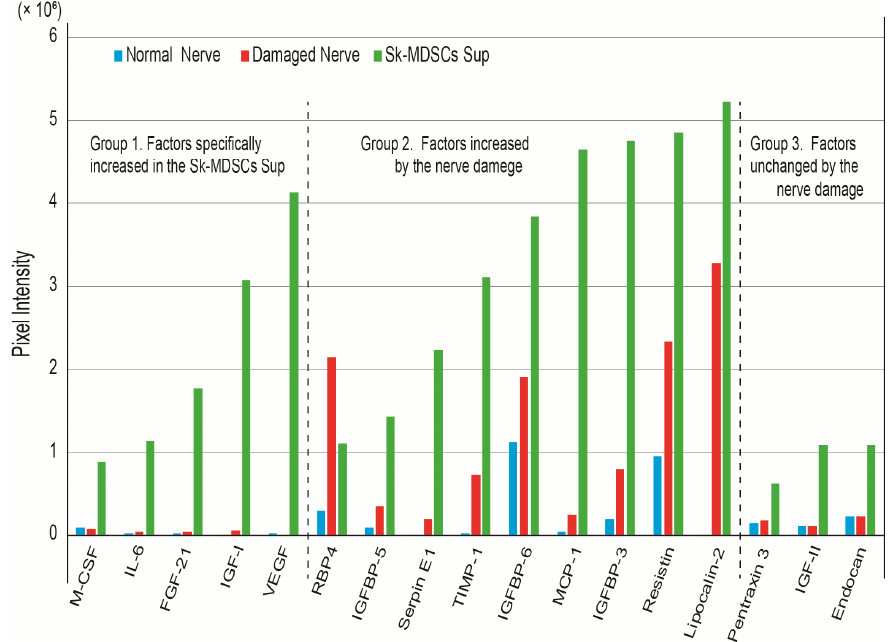
Figure 6. The main factors of the cytokine cocktail. These were determined by comparison of Group 1: factors specifically increased/detected in the Sk ‐ MSC supernatant and almost undetected in both the normal and damaged nerve; Group 2: factors increased in the damaged nerve (minimally 1.5 ‐ fold greater in normal vs. damaged); and Group 3: factors unchanged by nerve damage but increased in Sk ‐ MSCs. Significant change of values for the baseline was determined using >0.1 ‐ pixel intensity. Sk ‐ MSCs, skeletal muscle ‐ derived stem cells. From the above refinement, the factors were narrowed down to 17 against 78.